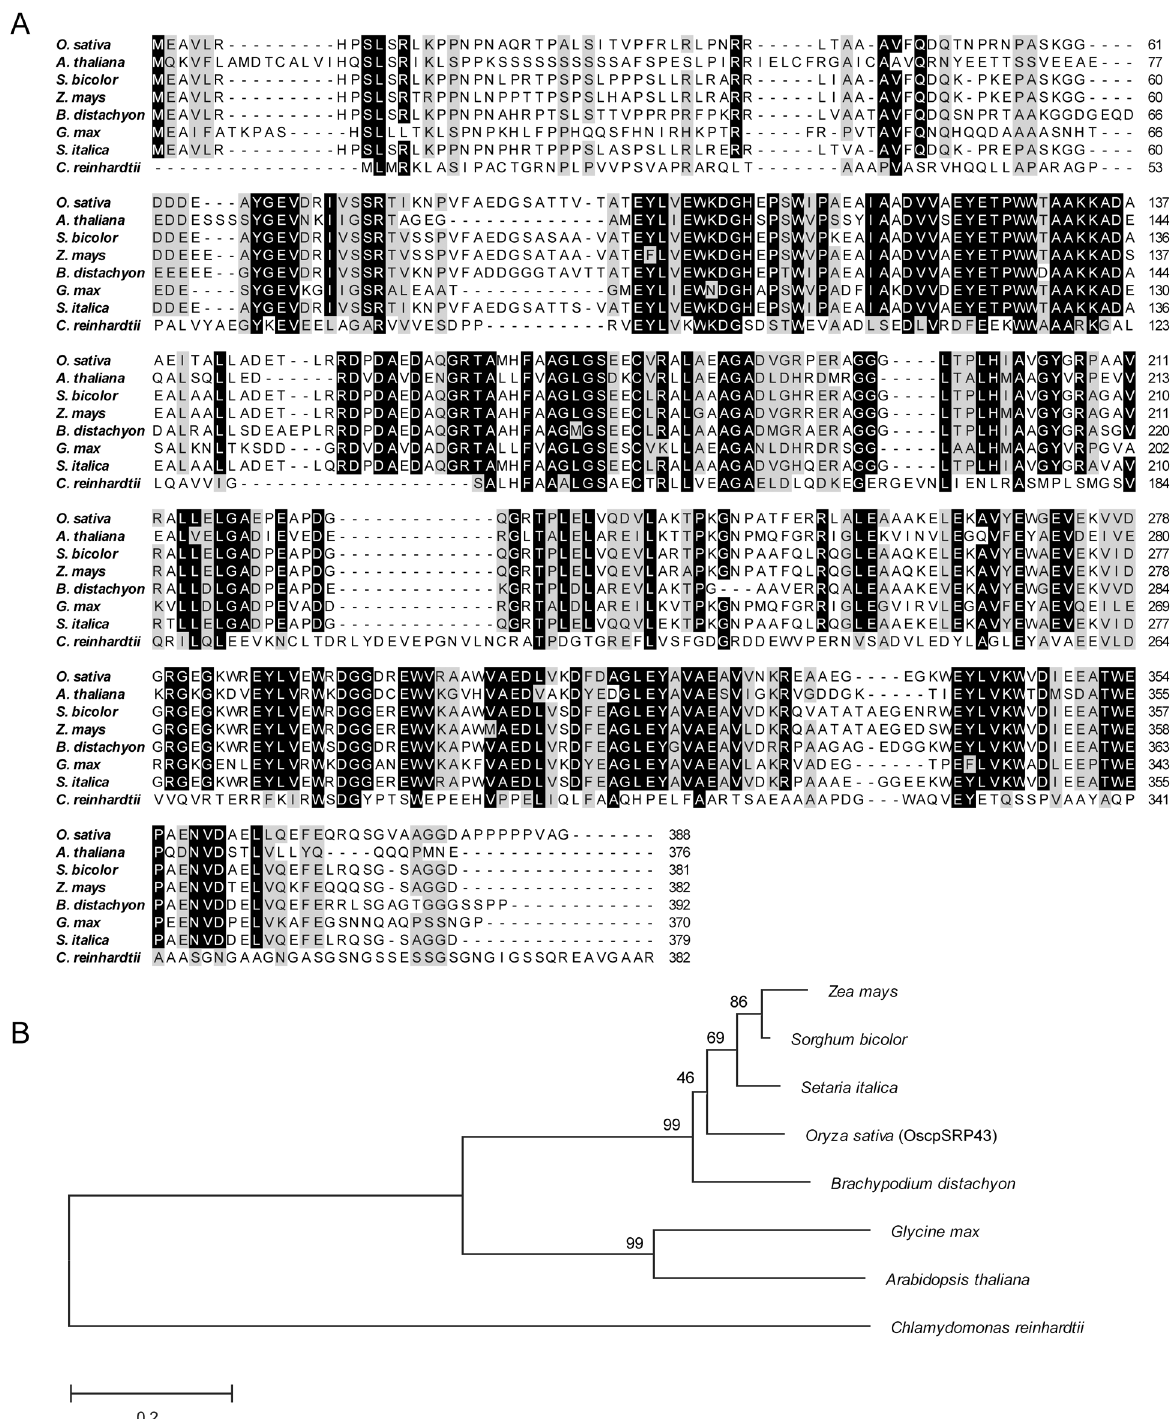
Fig 6. Sequence aligment and phylogenetic analysis of OscpSRP43 homologs. A, Comparison of amino acid sequences of OscpSRP43 homologs. Residues identical to OscpSRP43 are shaded. Accession numbers for the respective protein sequences are as follows: Zea mays (NP_001168899); Sorghum bicolor (XP_002465920); Setaria italica (XP_004985832); Oryza sativa (NP_001048866); Brachypodium distachyon (XP_003562136); Glycine max (XP_003537753); Arabidopsis thaliana (NC_003071) and Chlamydomonas reinhardtii (AGC59877). B, Dendrogram of OscpSRP43 hommologs.